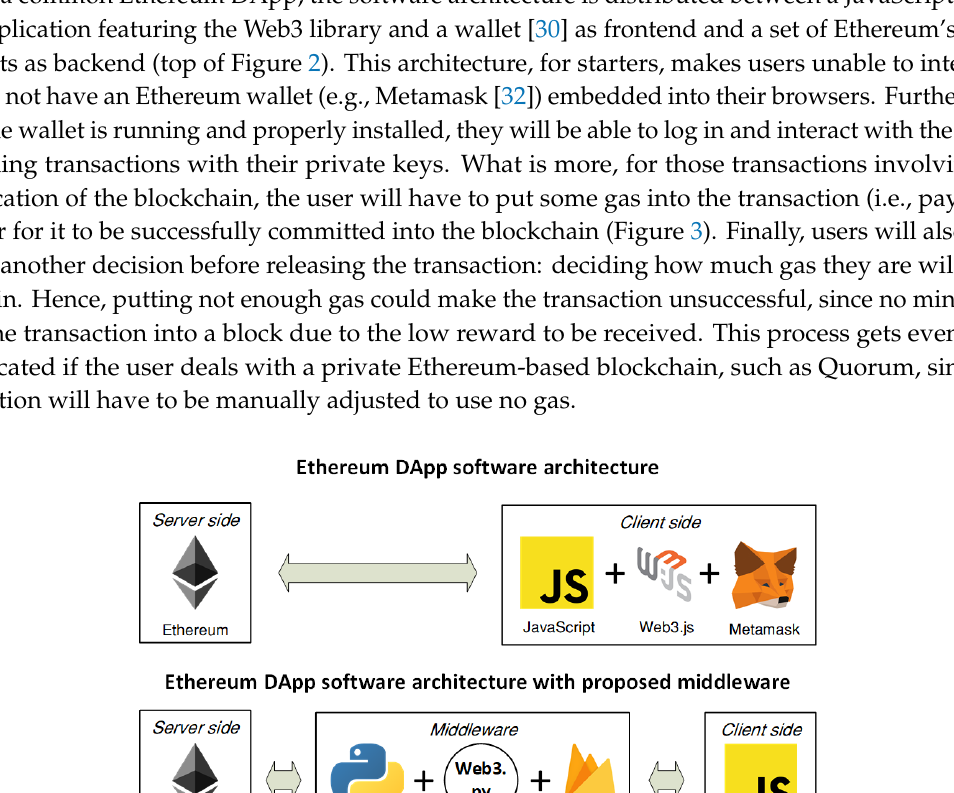
Figure 3. Sending a transaction to an Ethereum Smart Contract ( a ) and deciding how much gas to spend ( b ) and customizing it for a private Blockchain ( c ).